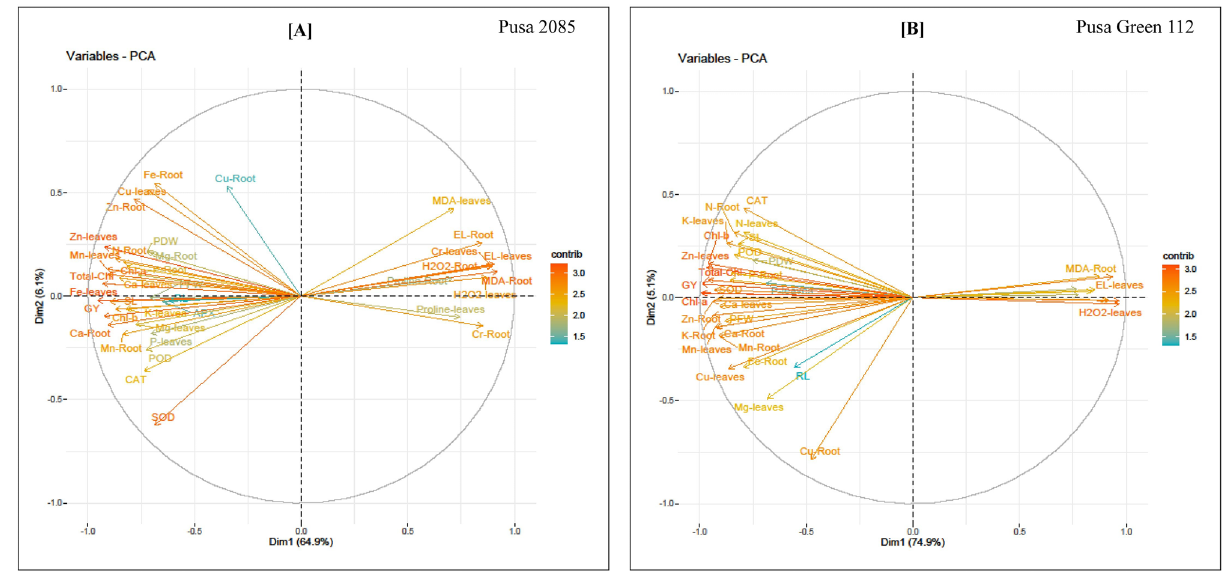
Figure 10. The loading plots of the principal component analysis (PCA) showing the different measured attributes of both chickpea cultivars grown in soil in the presence of 0 and 120 μM Cr and 120 μM Cr + 100 mM glycine betaine (GB). The various attributes used in the figures are as follows: Cr-leaves, Cr-Root, H 2 O 2 -Root, H 2 O 2 -leaves, Proline-Root, Proline-leaves, EL-Root, MDA-leaves, MDA-Root, EL-leaves, Cu-Root, Mg-leaves, P-leaves, RL-Root length, PDW-Plant dry weight, Fe-Root, Mn-Root, Cu-leaves, SOD-superoxide dismutase, K-Root, SL-Shoot length, Zn-Root, N-leaves, K-leaves, APX-ascorbate peroxidase, GY-Grain yield, Chl- a , total chlorophyll, Zn-leaves, Chl- b , PFW-Plant fresh weight, Ca-Root, Mn-leaves, CAT-Catalase, N-Root, POD- Peroxidase, Mg-Root, P-Root, Ca-leaves, and